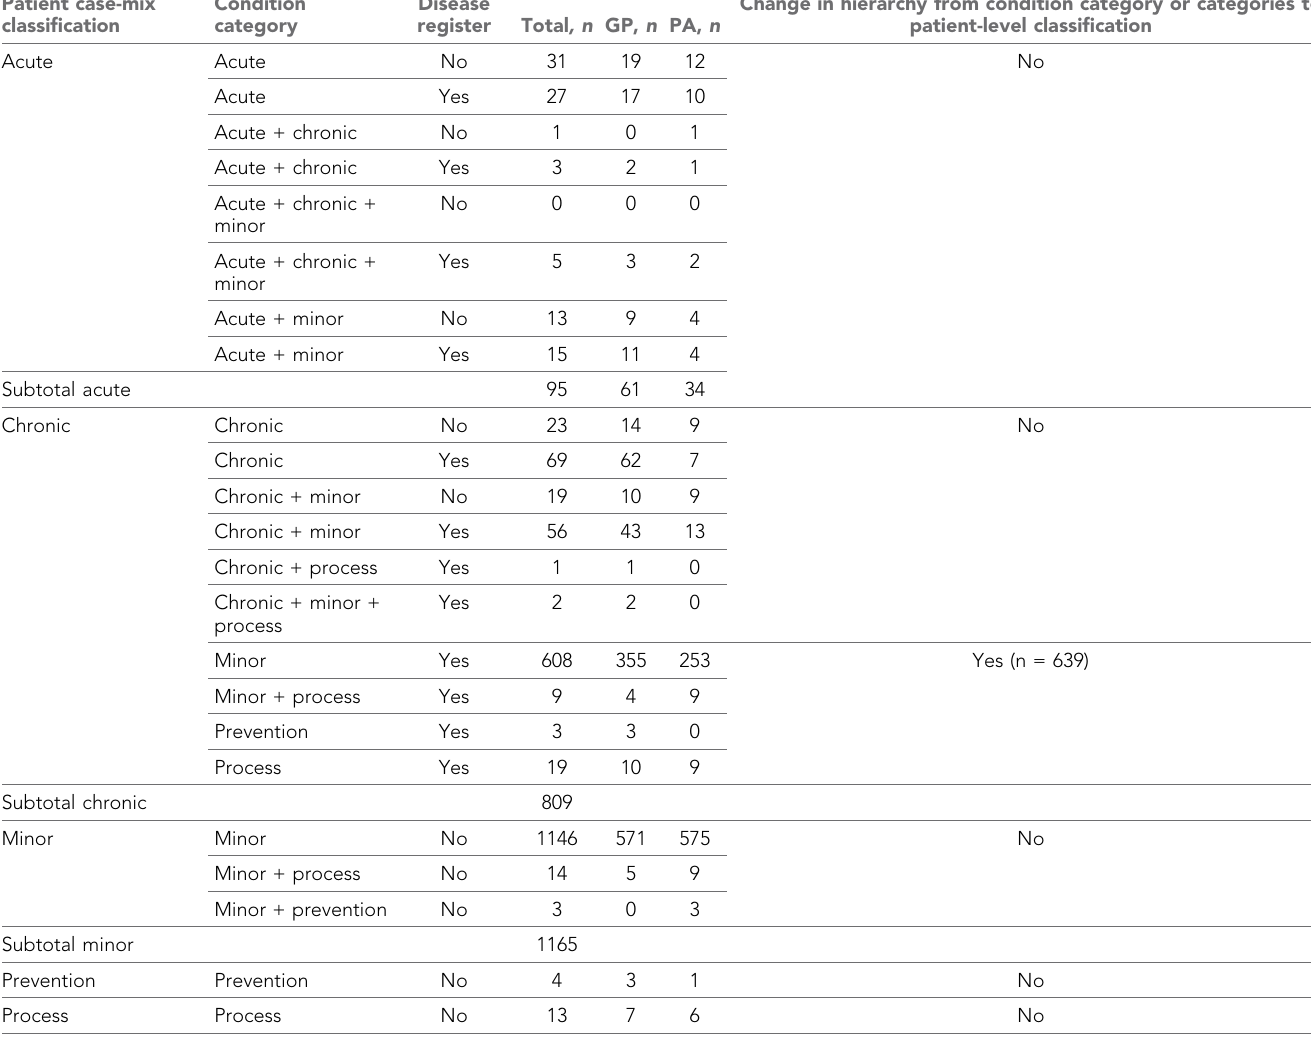
Table 1. Listing of presenting condition classification and disease register combinations forming patients’ case-mix classification Patient case-mix Condition classification